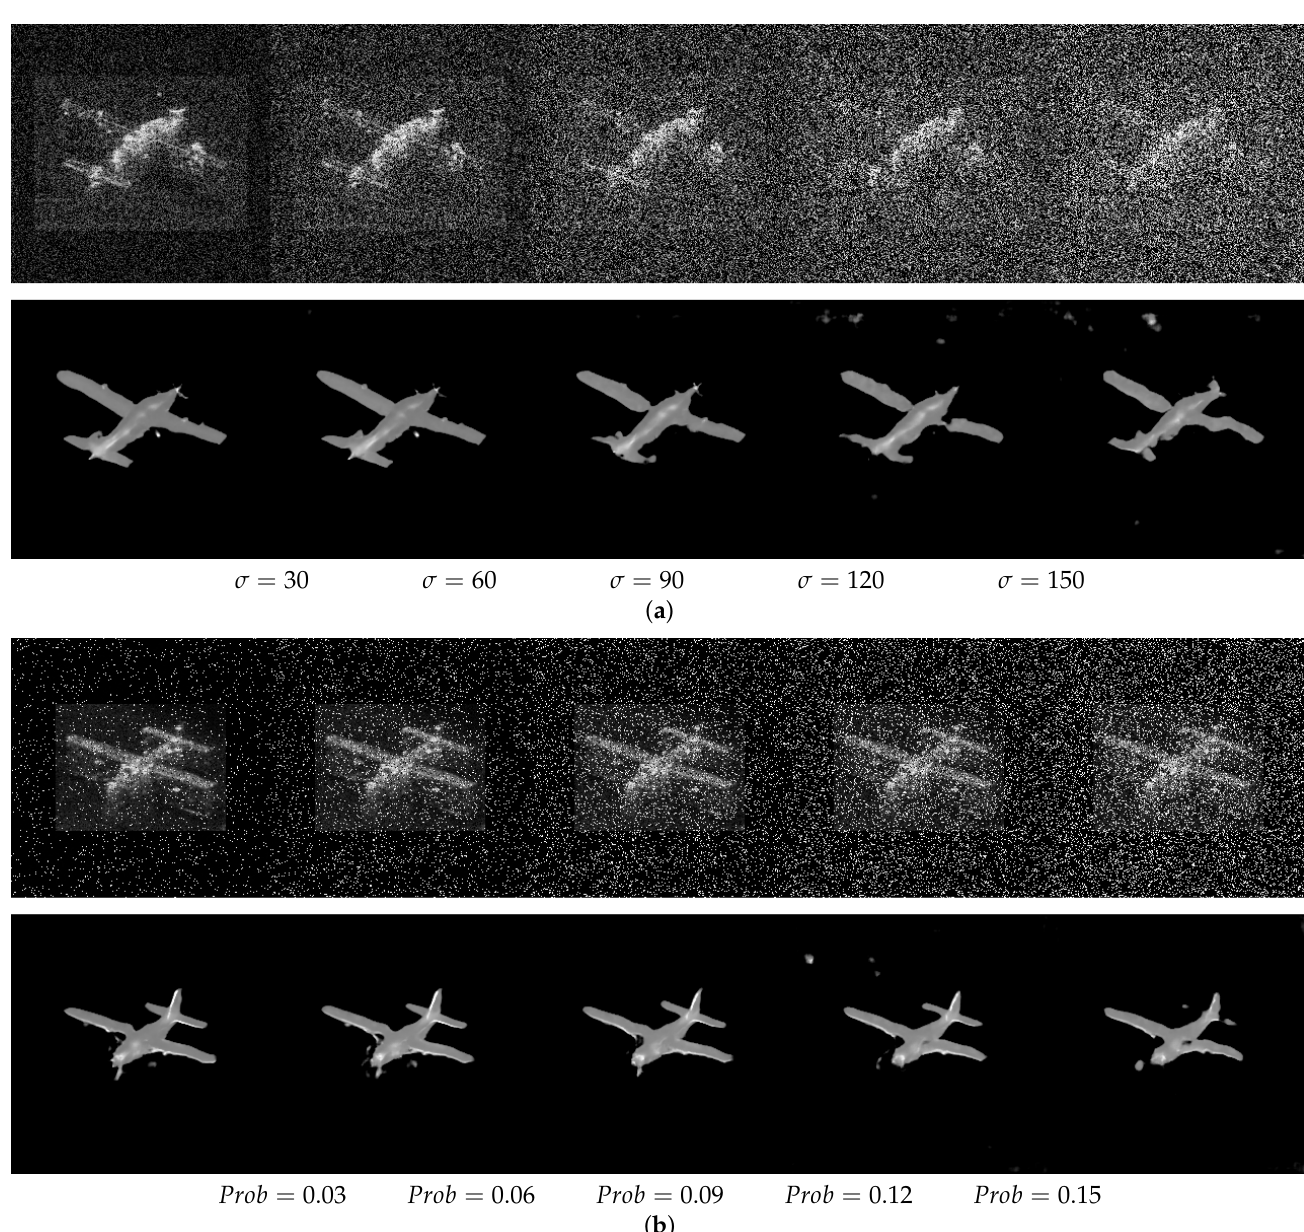
Figure 7. Translation results of noisy SAR images. ( a ) SAR images with Gaussian noise of different σ added (the top row) and corresponding translated images (the following row); ( b ) SAR images with salt-and-pepper noise of different probabilities added (the top row) and corresponding translated images (the following